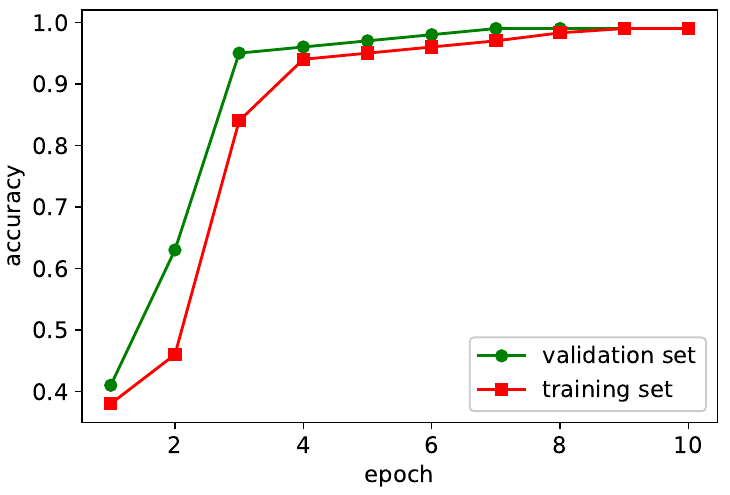
Figure 5. Accuracy curve of feature fusion detection model on validation set and training